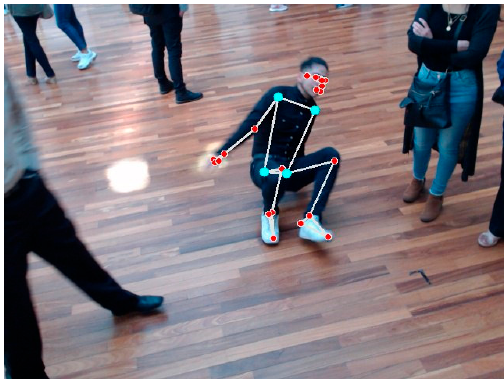
Figure 5. Skeletonization of a person by means of a fall detection algorithm.